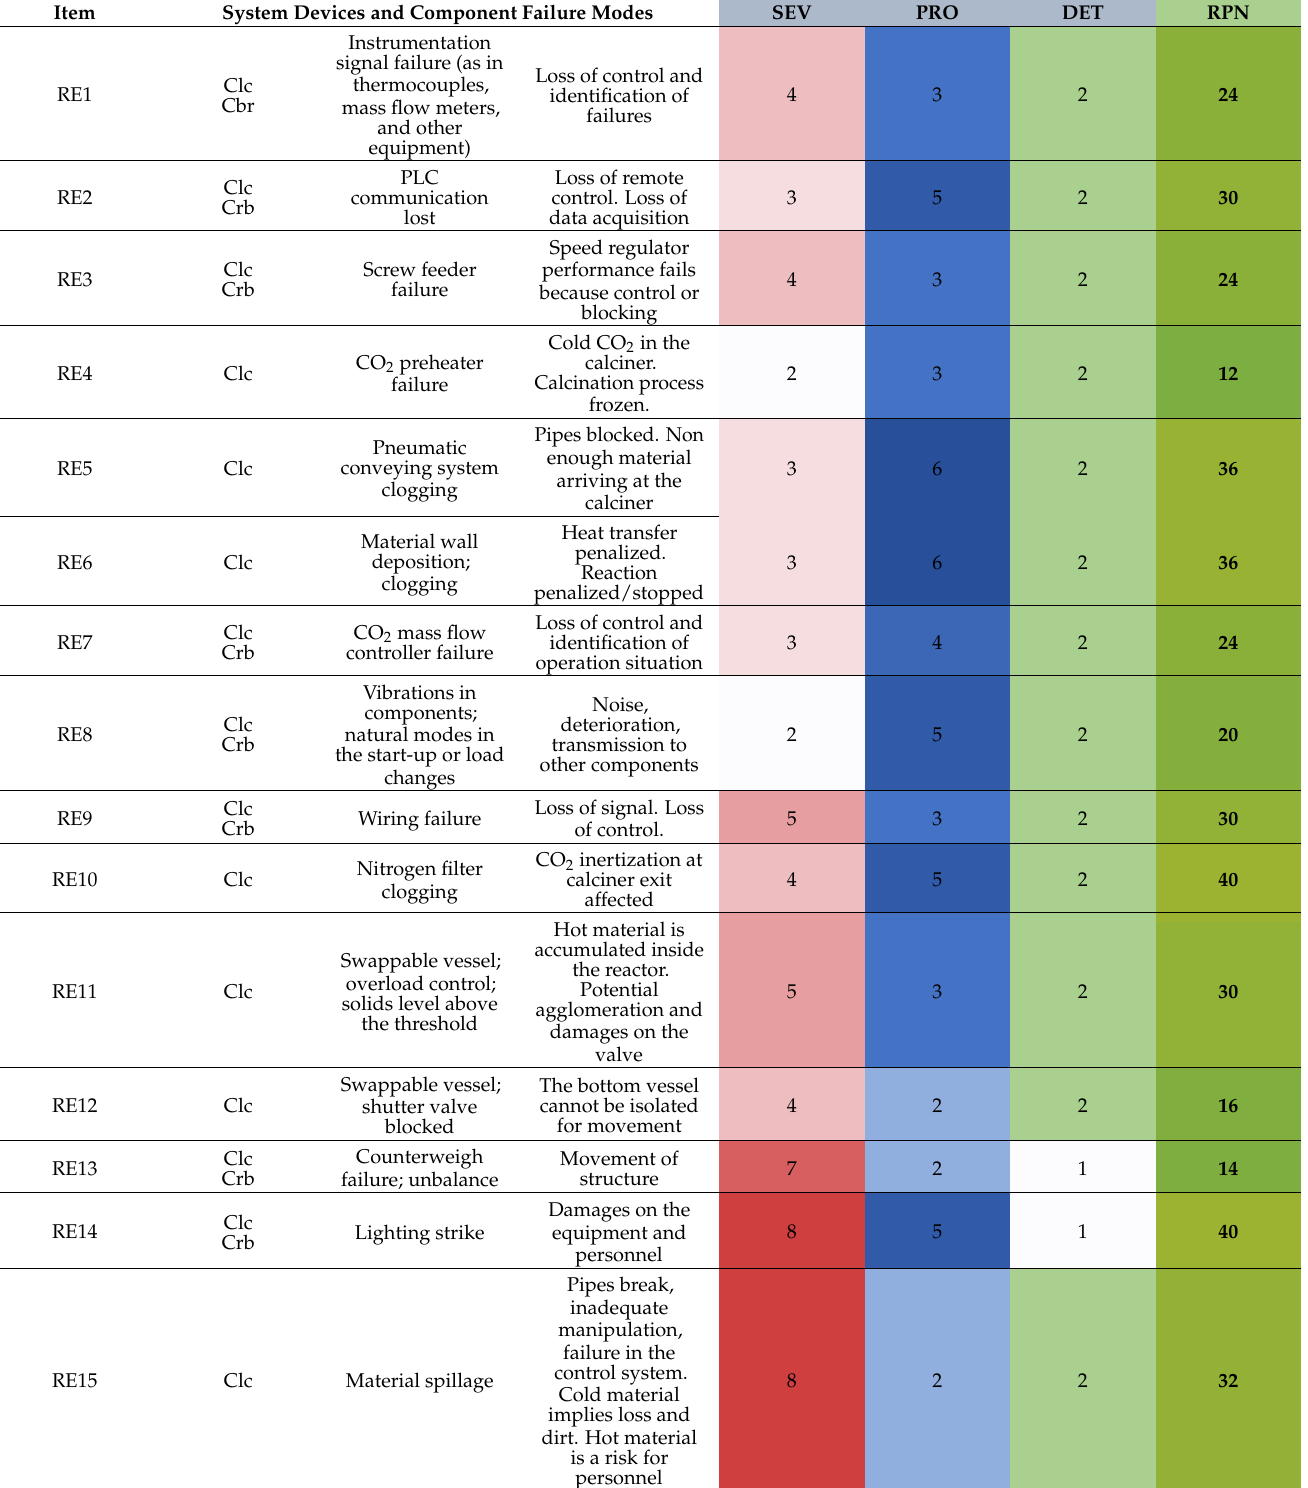
Table 7. Data collection and risk assessment of the FMEA analysis of the reactors (calciner and carbonator). Clc, calciner; Crb,